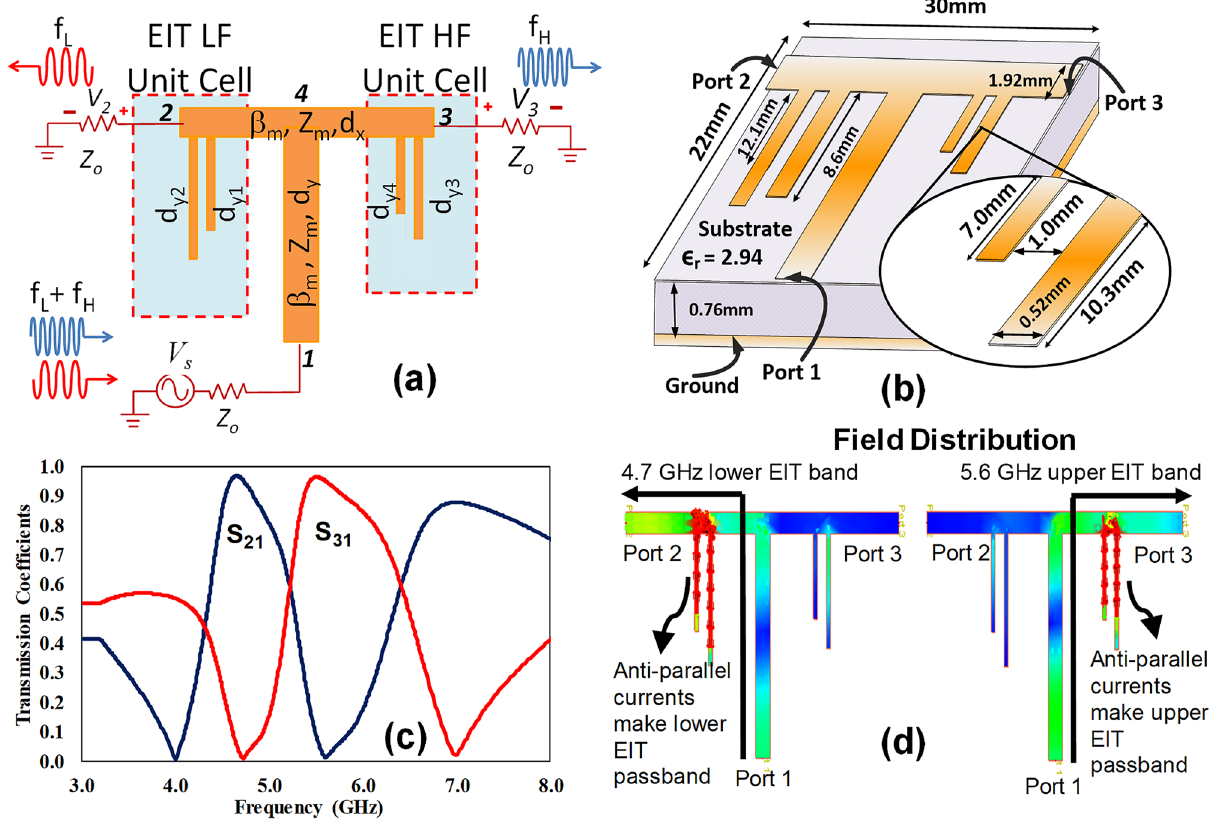
Figure 1. ( a ) Schematic model of the proposed microstrip Diplexer based on the EIT-like effect. The power injected at node 1 is discriminated in frequency such that the 4.6 GHz spectral component appears at port-2 and 5.5 GHz at port-3. Each transmission line segment is modelled by its forward transmission matrix. All the feeding lines have a characteristic impedance of 50 Ω and the stubs 100 Ω ( b ) The diplexer implemented on Rogers 6002 substrate of ε r = 2.94. ( c ) Transmission coefficients s21 and s31 show the passbands at the design frequencies. The high isolation can be seen by recognizing the transmission null of one channel occurring at the passband of the other. ( d ) Numerical simulations of current distributions performed in Agilent’s Momentum full-wave simulator in the two EIT-like passbands. The two stubs in the excited EIT-like structure show anti- parallel currents indicating the destructive